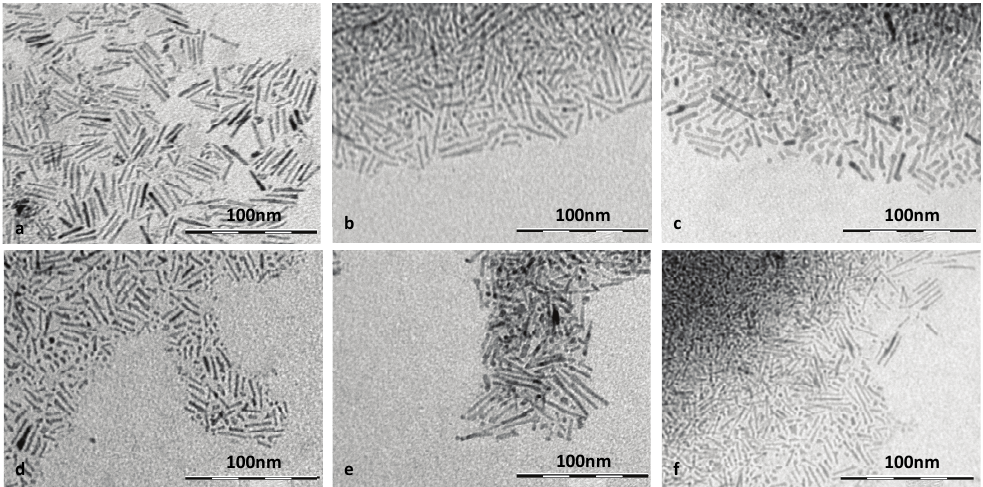
Figure 1. TEM images of the boron-modified nanocrystals, TiO TOB3 ( c ); TOB4 ( d ); TOB5 ( e ) and TOB6 ( f ). Molar ratios between titanium tetra-isopropoxide (TTIP) and oleic acid are indicated in Table